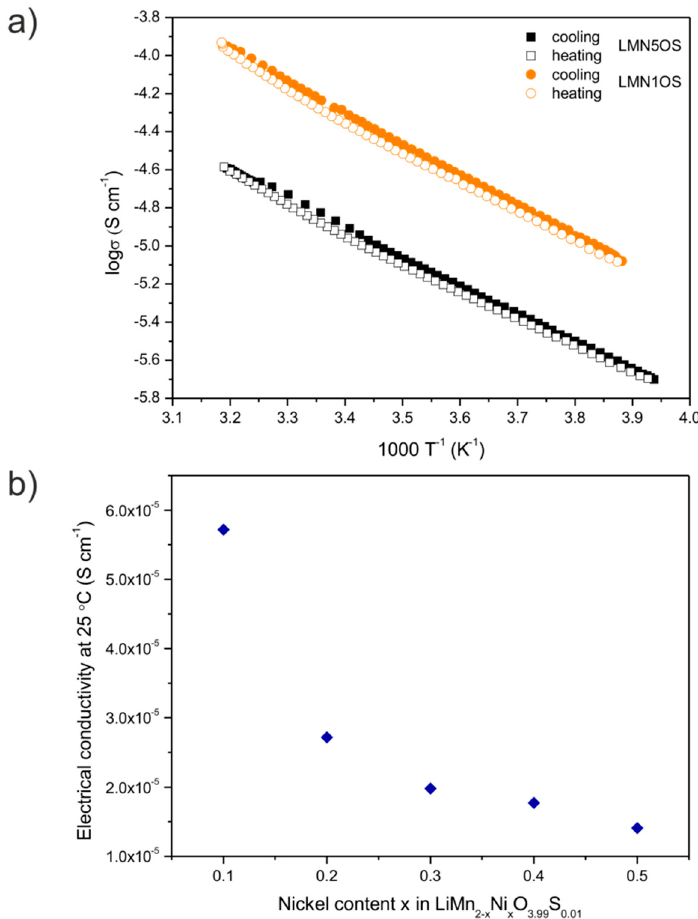
Figure 5. ( a ) The Arrhenius plots of log σ vs. 1000 T − 1 of LiMn 1.5 Ni 0.5 O 3.99 S 0.01 and LiMn 1.9 Ni 0.1 O 3.99 S 0.01 spinel materials; and ( b ) the electrical conductivity estimated at room temperature as a function of nickel content x in LiMn 2 − x Ni x O 3.99 S 0.01